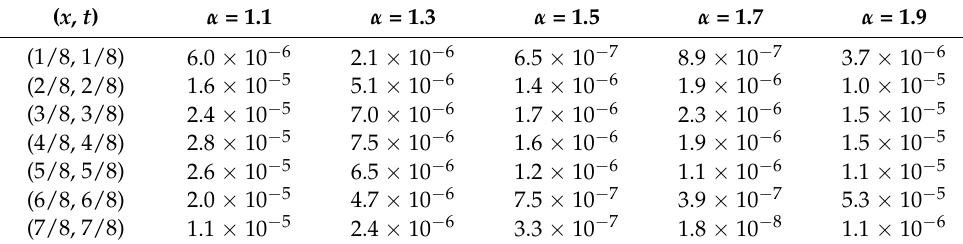
Table 2. The absolute errors of wavelet solution of Example 2 for different α .